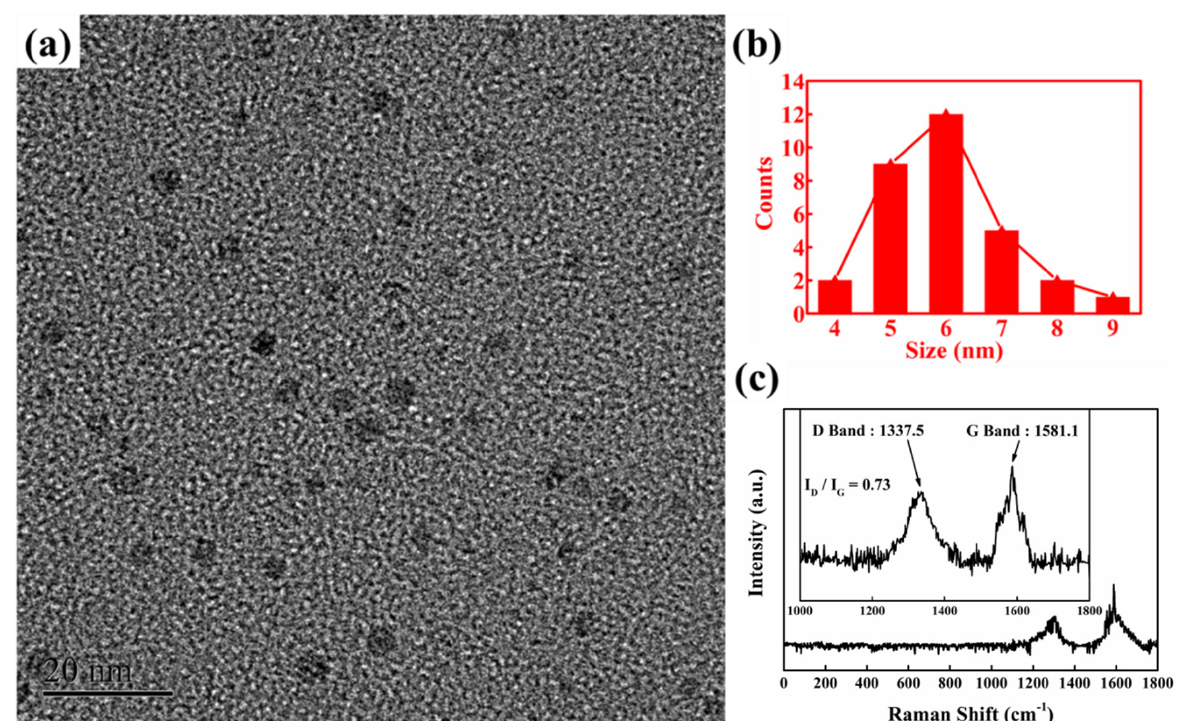
Figure 1. ( a ) TEM images of N-GQD, ( b ) particle size distribution of N-GQD, and ( c ) Raman spectrum of N-GQD.